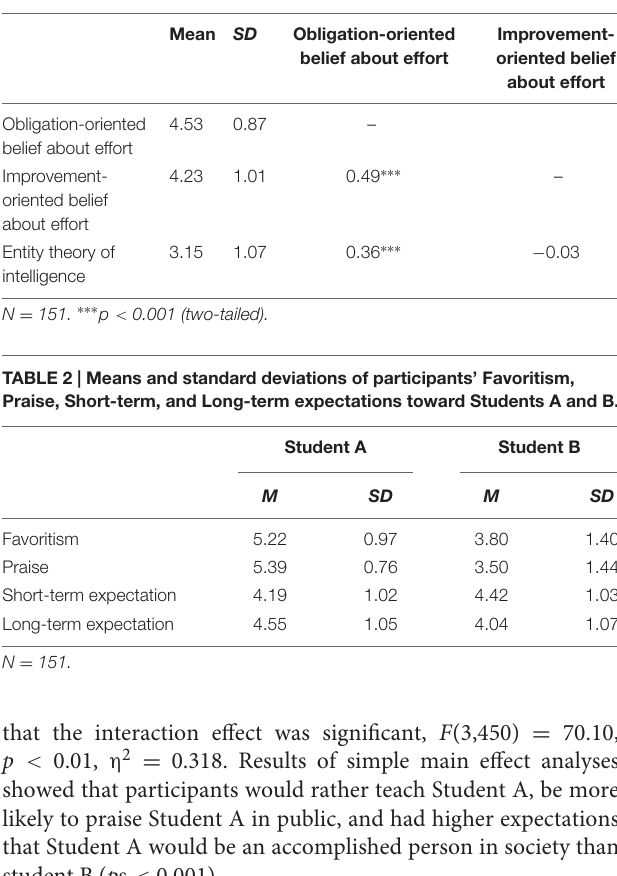
TABLE 1 | Means, standard deviations, and correlation coefficients among the beliefs about effort and intelligence factors.